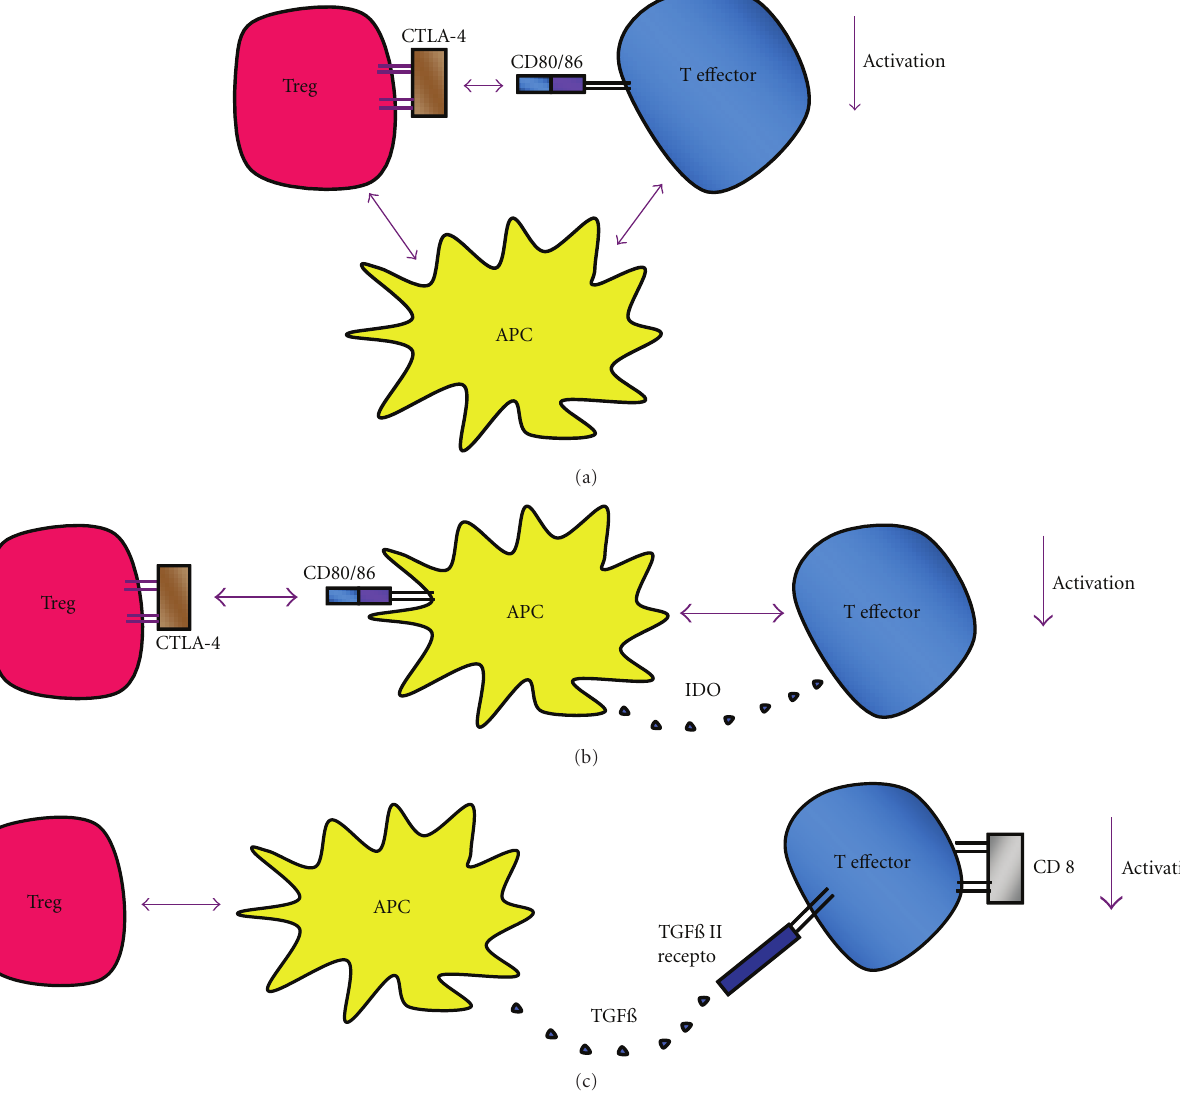
Figure 1: Mechanism(s) of suppression: illustrates various molecular and cellular mechanisms to explain how Tregs can suppress host immune responses. (a) In contact dependent mechanism the costimulatory molecules, namely, CD80/86, interact with CTLA-4 to trigger immunosuppressive signals on T e ff ector cells leading to subtle e ff ector cell function. (b) In contact dependent mechanism, CD80/86 expressed in APC interact with CTLA-4 leading to consequential signalling and activation of IDO leading to immunosuppressive e ff ects. (c) The crosstalk of TGFß expressed in APC to TGFß II receptor leads to immunosuppressive cytokine-mediated suppressor